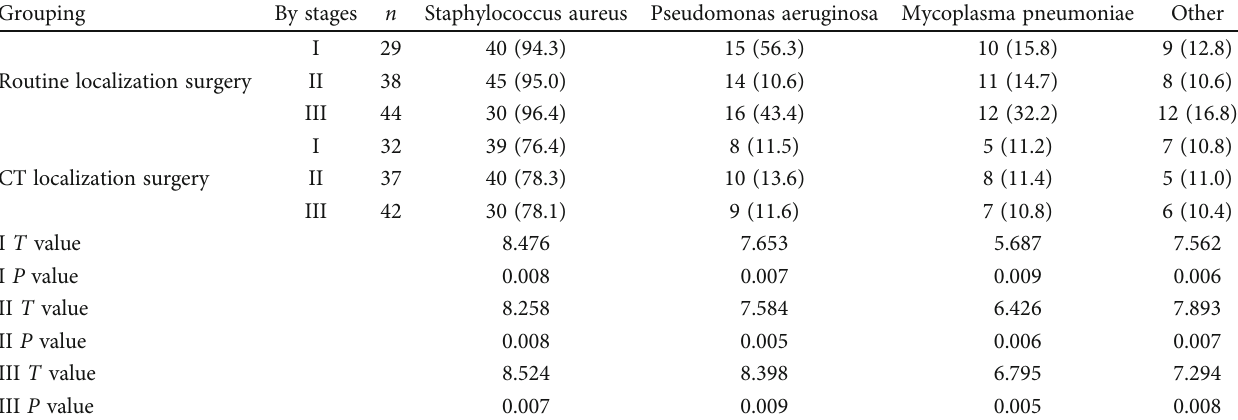
Table 4: Comparison of the incidence rate of infectious pneumonia (data source: self-statistics of the study). Grouping By